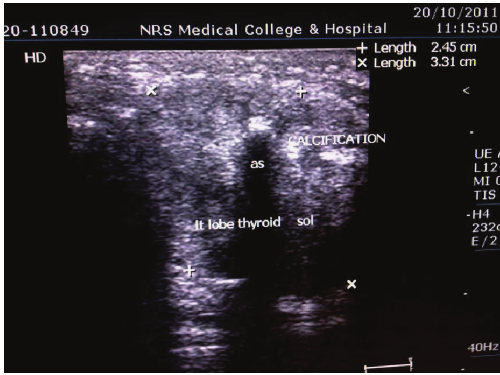
Figure 1: Contrast enhanced CT scan showing soft tissue mass at posterolateral wall of upper trachea (arrowhead).